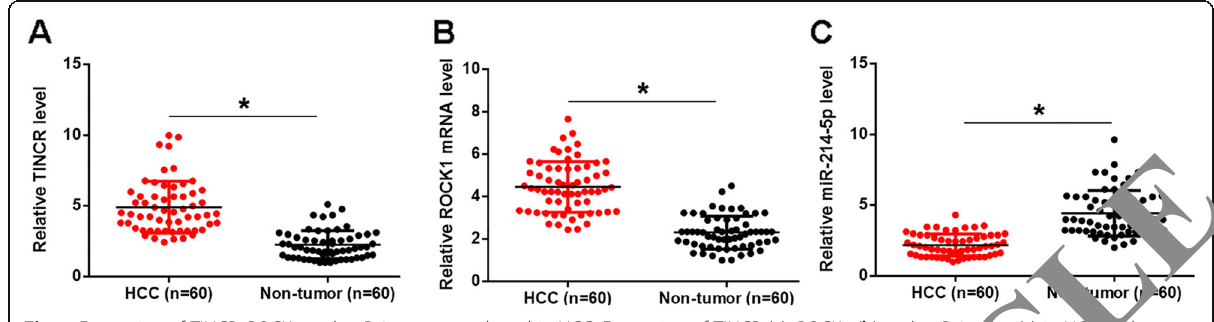
Fig. 1 Expression of TINCR, ROCK1 and miR-214-5p was altered in HCC. Expression of TINCR ( a ), ROCK1 ( b ) and miR-214-5p ( c ) in HCC and non- tumor tissues was detected by performing qPCR. All qPCR reactions were performed 3 times. Expression levels were compared between non- tumor and HC tissues by paired t test (*, p < 0.05)